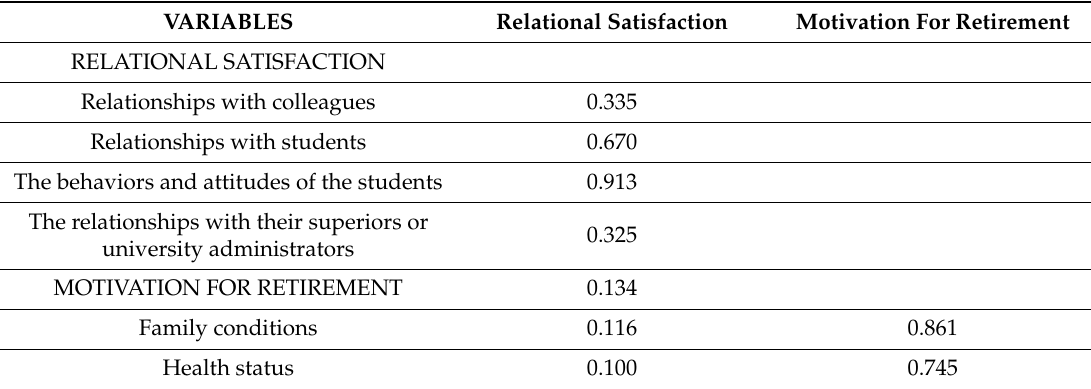
Figure 5. Path diagram of model 3: influence on the relational satisfaction on the motivation to retire of nonactive professors. Table 5. Standardized total e ff ects of model